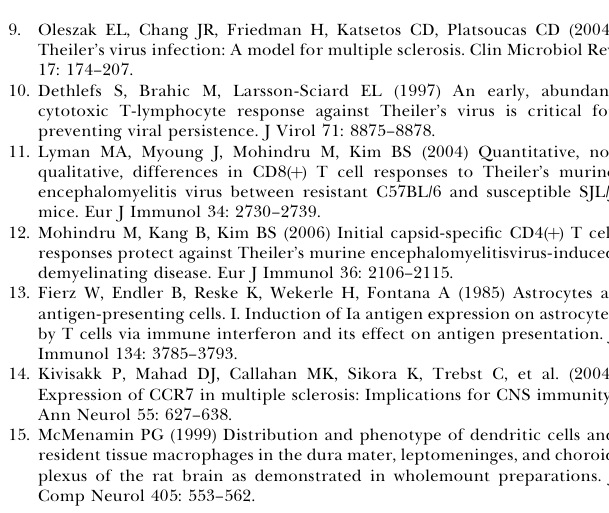
(C) Virus titers in the culture supernatants of the separated cells were analyzed by plaque assay. The differences between the values of